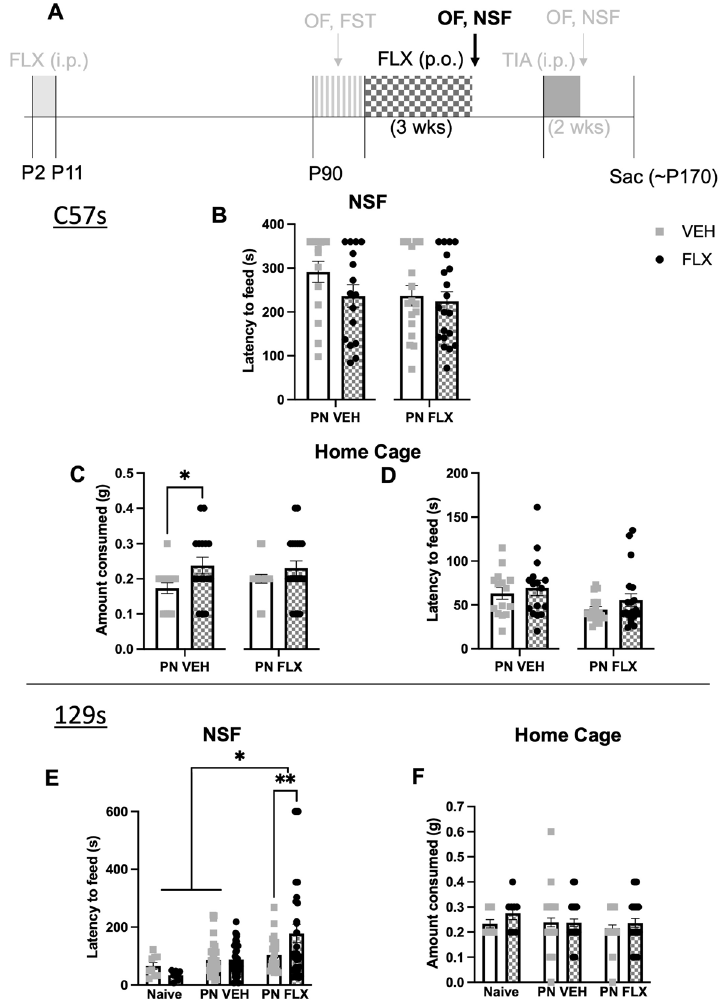
Figure 3. No effect on NSF behavior following adult fluoxetine treatment in C57 PN-FLX mice , and increased latency to feed in the NSF following adult fluoxetine treatment in 129 PN-FLX mice. ( A ) Timeline of experiment: The window for developmental administration of fluoxetine, as well as prior phenotyping and future experiments are in faded light grey; Black and checkered gray indicate chronic fluoxetine administration in adulthood and follow up NSF and OF tests. ( B ) Latency to feed in the NSF in C57 mice (PNVEH: unpaired t-test, p = 0.1314; PNFLX: unpaired t-test, p = 0.6949). ( C ) Home cage consumption in C57 mice (PNVEH: unpaired t-test, * p = 0.0341; PNFLX: unpaired t-test, p = 0.2393) ( D ) Latency to feed in the home cage in C57 mice (PNVEH: unpaired t-test, p = 0.5860; PNFLX: unpaired t-test, p = 0.2044). ( E ) Latency to feed in NSF in 129 mice. (2-way ANOVA; interaction of PN exposure and adult FLX, F (2, 136) = 3.290, * p = 0.0402; main effect of PN exposure, F (2, 136) = 8.371, *** p = 0.0004, main effect of adult FLX, F (1, 136) = 0.6054, p = 0.4379; Bonferroni post-hoc, significant increase in latency to feed with adult FLX treatment in PN-FLX 129 mice, ** p = 0.0096). ( F ) Amount of food consumed in the home cage in a 5-min period in 129 mice. (2-way ANOVA; interaction of PN exposure and adult FLX, F (2, 136) = 0.5200, p = 0.5957, main effect of PN exposure, F (2, 136) = 0.7566, p = 0.4712, main effect of adult FLX, F (1, 136) = 1.356, p = 0.2463). Interaction effects from the 2-way ANOVA are represented as significance lines between naïve, PNVEH, and PNFLX 129 groups, and the Bonferroni post-hoc results are depicted as significance lines within the PNFLX 129 group. Light gray squares represent adult vehicle-treated animals. Black circles and checkered bars represent adult fluoxetine-treated animals. 129 s: N = 9 naïve-VEH, 8 naïve-FLX, N = 36 PNVEH-VEH, 32 PNVEH-FLX, 27 PNFLX-VEH, 30 PNFLX-F; C57s: N = 15 PNVEH-VEH, 16 PNVEH-FLX, 17 PNFLX-VEH, 20 PNFLX-FLX. Bars represent mean. Error bars represent standard error. * p < 0.05, ** p < 0.01, *** p < 0.001, **** p <